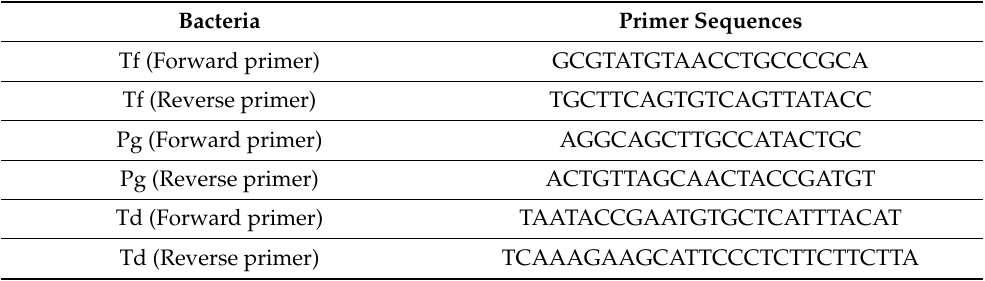
Table 1. Primer sequences for assessment of red-complex bacteria using